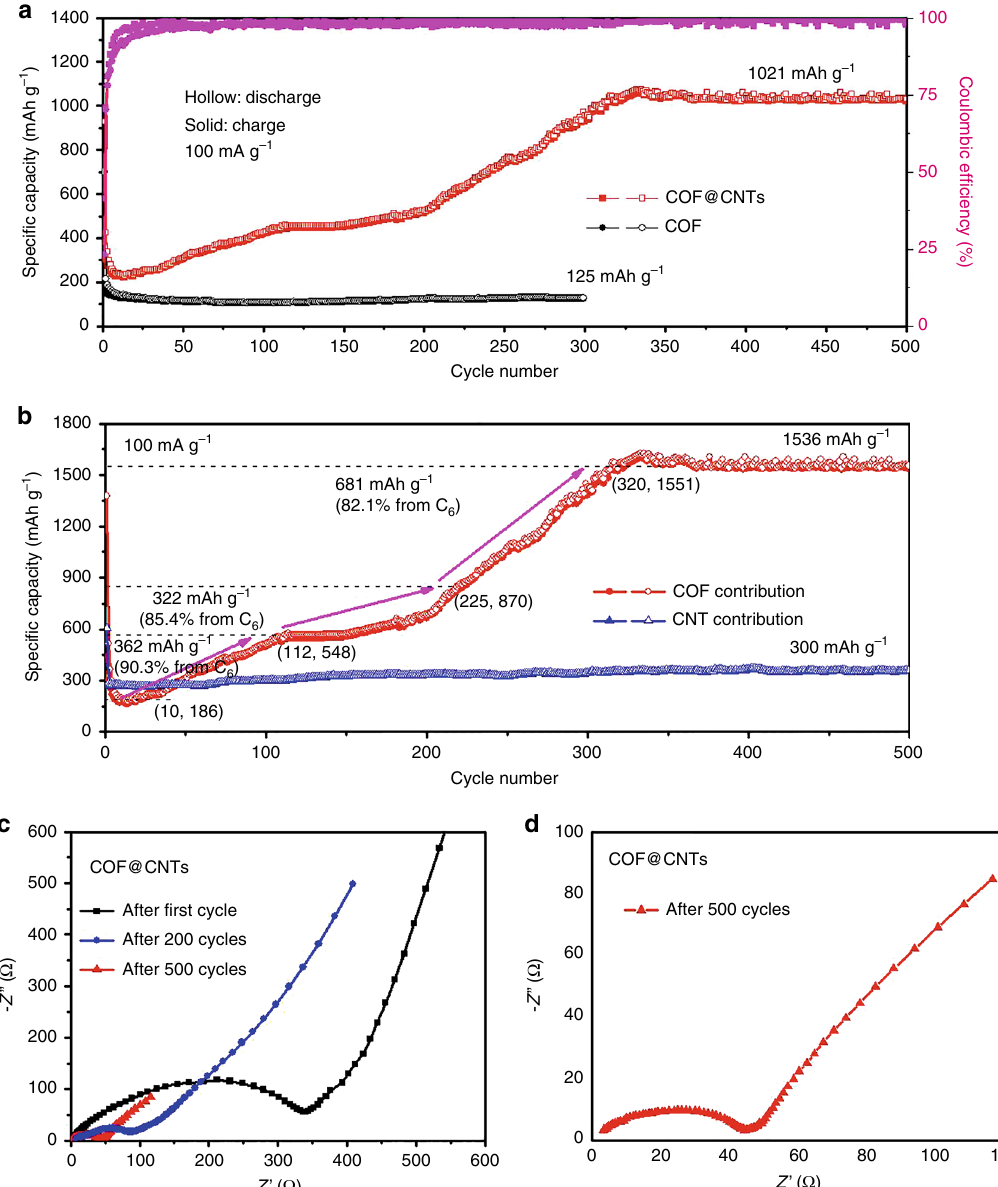
Fig. 3 Electrochemical performances of the COF@CNTs anode. a Cycling performances of the COF and COF@CNTs at 100 mA g − 1 . b Capacity contribution of COF (based on the mass of COF) in COF@CNTs at 100 mA g − 1 . c Nyquist plots of the COF@CNTs after the fi rst 200 and 500 cycles. d The enlarged Nyquist plots after the 500th